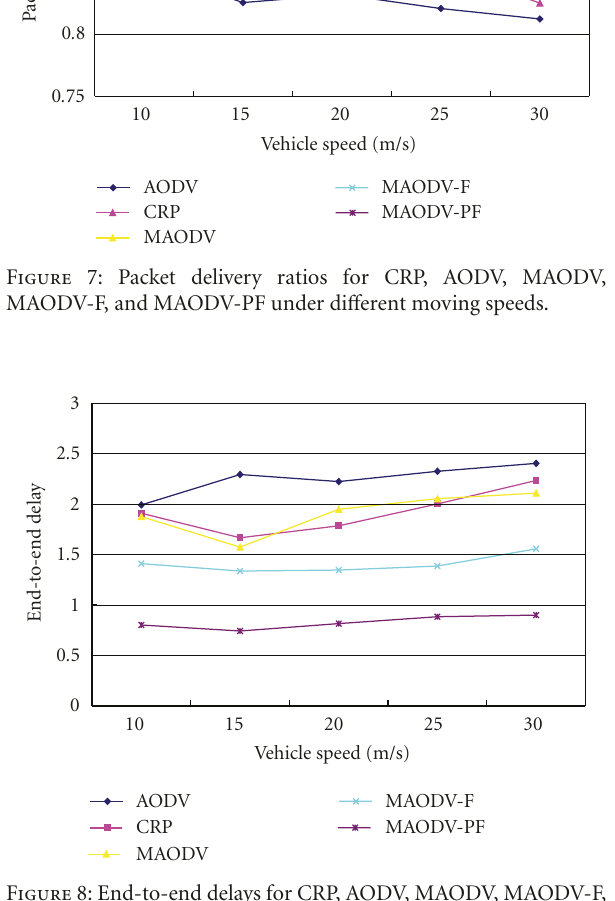
Figure 8: End-to-end delays for CRP, AODV, MAODV, MAODV-F, and MAODV-PF under di ff erent moving speeds.